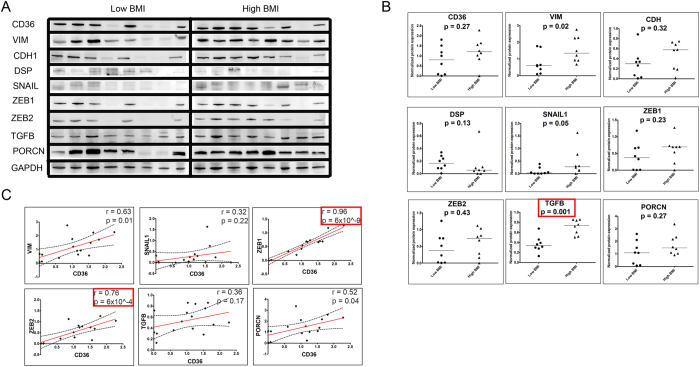
CD36 and EMT marker expression in human HCC tumors.(A) Western blots showing expression levels of CD36 and various EMT markers in tumor samples grouped according to BMI. High BMI group (n = 8) represents tumor samples obtained from individuals with BMI ≥ 30 and low BMI group (n = 8) indicates individuals with BMI ≤ 25. Equal amounts of sample (40 μg) were loaded in each well, run under identical conditions and blotted with specific primary antibodies against the indicated proteins. For clarity, blots have been cropped to show relevant bands (full length blots are presented in Supplementary Fig. 3) (B). Expression levels of proteins were determined by quantifying the background-subtracted band intensities normalized to GAPDH. Each dot represents relative expression levels of individual samples, with the horizontal bar indicating the median of the distribution. P-values indicate significance of difference in means between low BMI and high BMI groups determined by Mann-Whitney U test, with red boxes marking significant associations from multivariate regression analysis. (C) Scatter plot showing association between CD36 (X-axis) and EMT marker (Y-axis) expression. The solid lines indicate linear fit and the dotted lines indicate 95% confidence intervals. r indicates Pearson’s correlation coefficient and p-values indicate significance of correlation (two-tailed), with red boxes marking significant associations from multivariate regression analysis (n = 16). Specific clinical data for each patient is available in Supplementary Table 3.